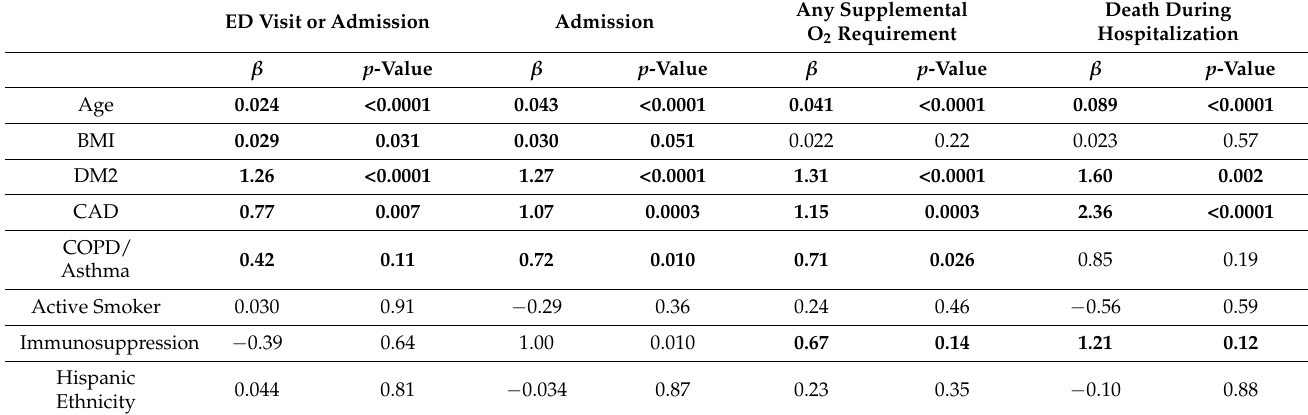
Table 2. Univariate logistic regression for COVID-19-related outcomes.